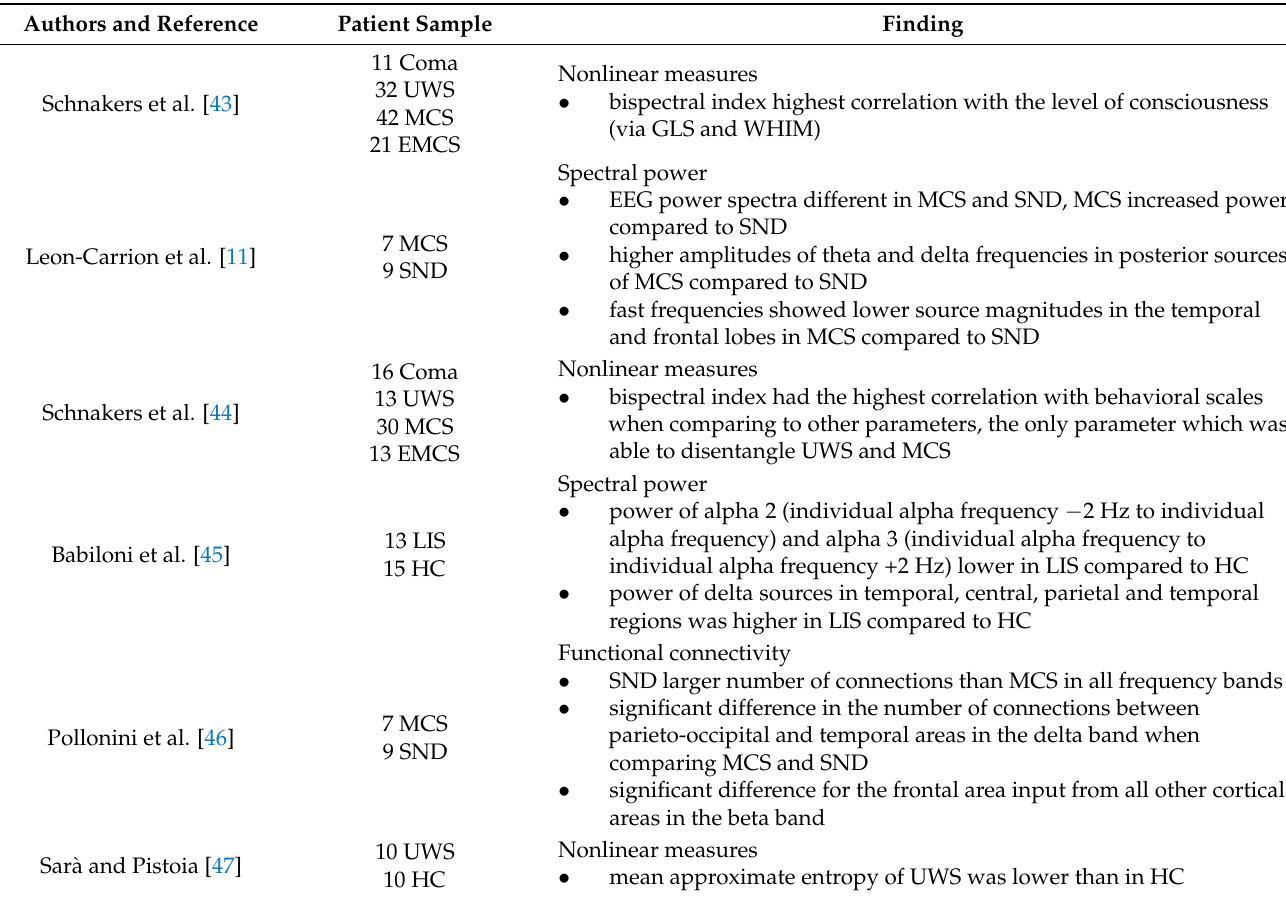
Table 1. Overview of findings for diagnosis and resting-state EEG; abbreviations can be found in Abbreviation. Authors and